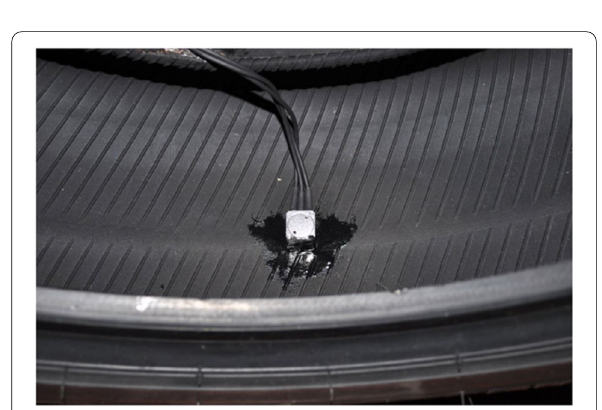
Figure 2 Using accelerometers to identify TRFC